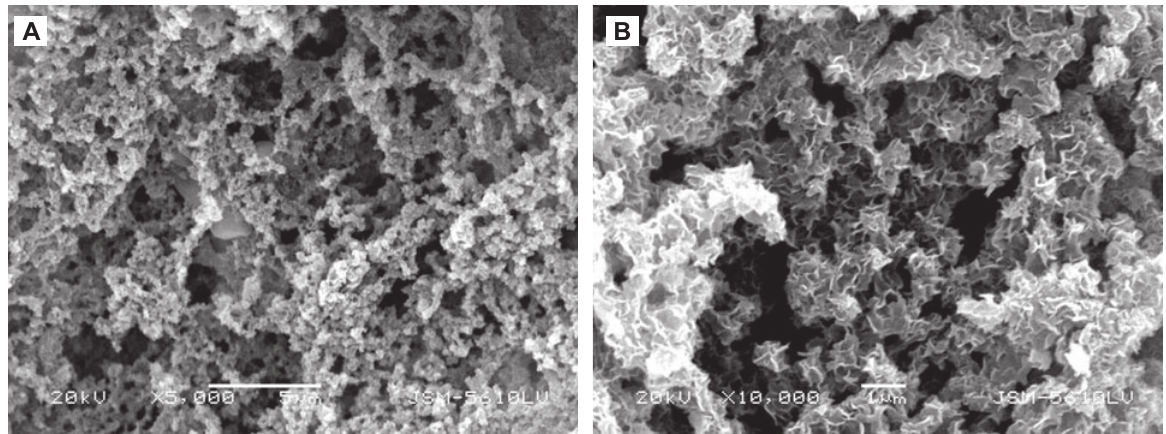
Figure 2 SEM images of as-prepared HAp/Col composite (sample HAp/Col-48). (A) Surface morphology with a lower magnifi cation; (B) cross-sectional fracture morphology at a higher magnifi cation.